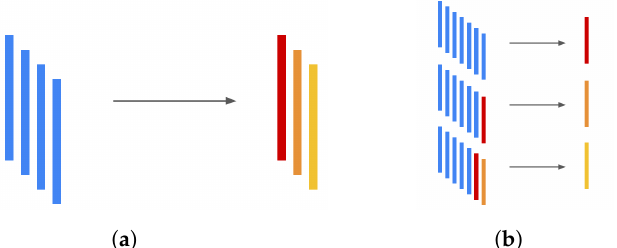
Figure 4. Schematic representation of the basic principles of the two U-Net regimes. Blue rods represent blocks of historical data (stacked SIC or weather maps), one for each day in the past. The leftmost is 6 days old, and the rightmost is for today (for 7-day historical input). Red, orange, and yellow rods represent model forecasts of SIC maps for the first, second, and third days in the future, respectively, (for a 3-day forecast). All the forecasts are made simultaneously in S-regime, while in the R-regime they are made one by one, and the model’s inputs are updated on each step. ( a ) S-regime scheme. ( b ) R-regime